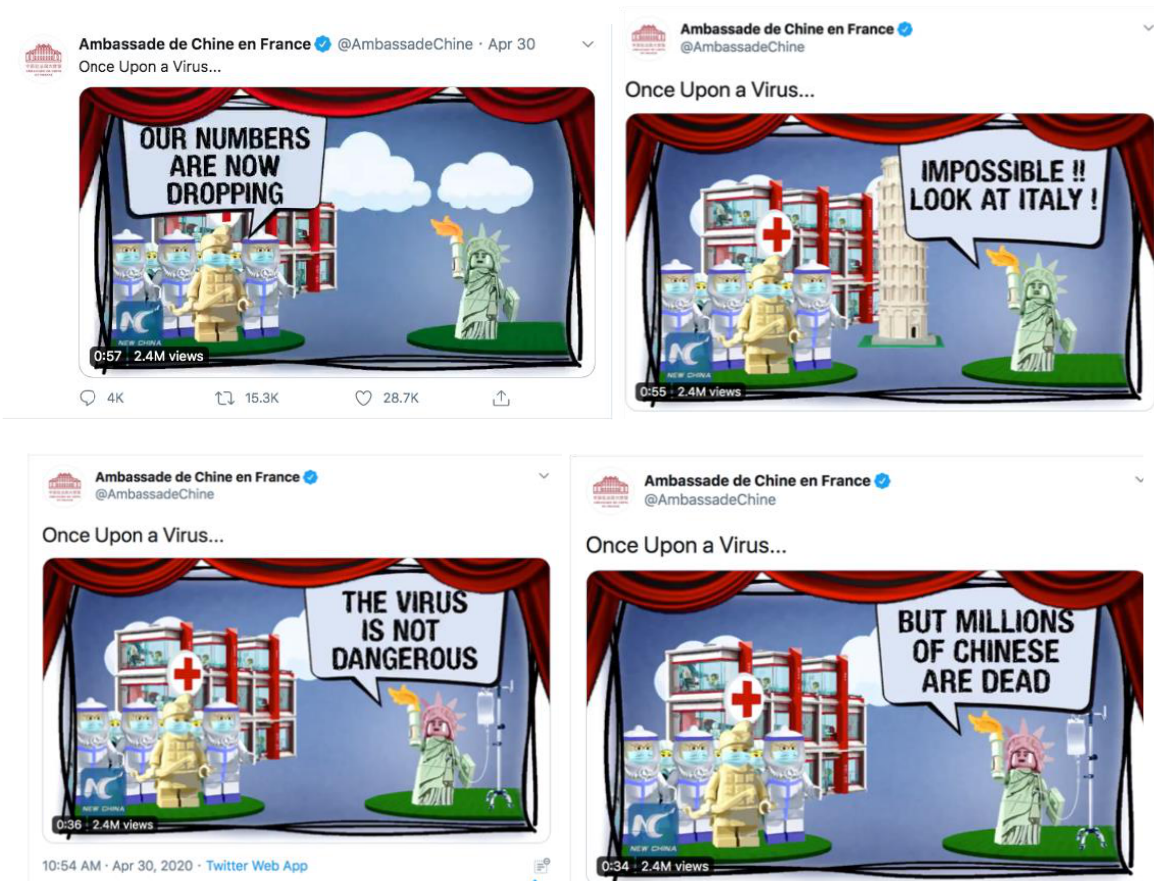
Figure 2: Stills from video shared by the Ambassador of China in